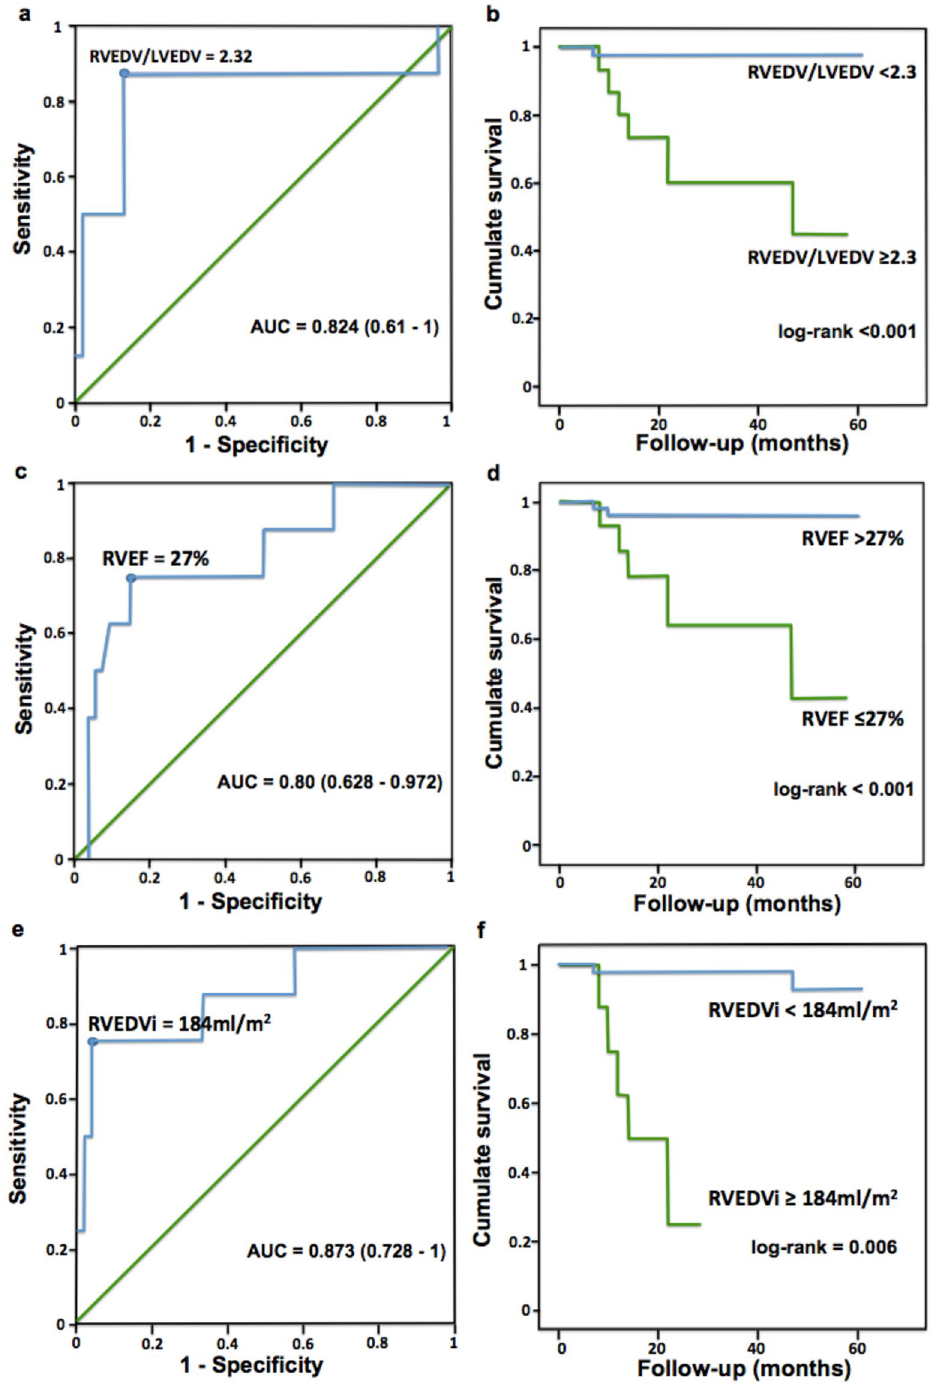
Figure 2. Receiver-operating curves and Kaplan-Meier survival analysis for RV/LV volume ratio, RVEDVi, and RVEF. ( a ) Optimal RV/LV volume ratio cutoff value to predict all-cause mortality. ( b ) The difference in event- free survival for “non-severe” vs. “severe” dilated RVs according to the RV/LV ratio. ( c ) Optimal RVEF cutoff value to predict all-cause mortality. ( d ) The difference in event-free survival for the optimal RVEF cutoff of 27%. ( e ) Optimal RVEDVi cutoff value to predict all-cause mortality. ( f ) The difference in event-free survival for “non-severe” vs. “severe” dilated RVs according to optimal cutoff for RVEDVi of 184 ml/m 2